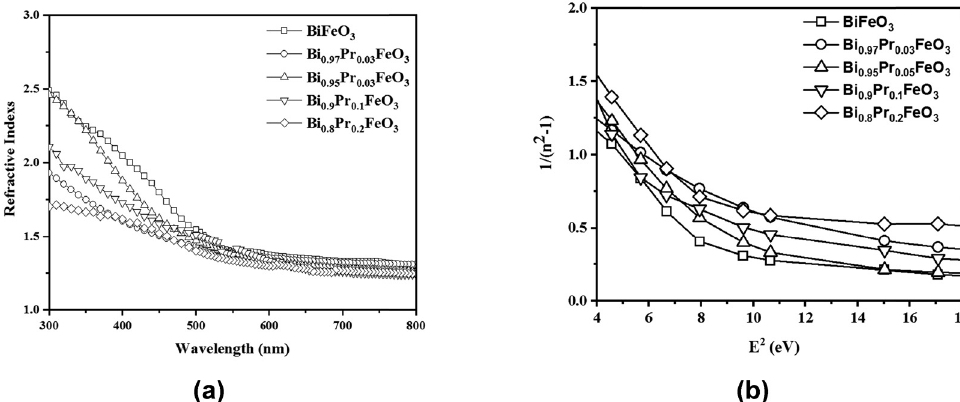
Figure 6: ( a ) Dispersion energy and ( b ) refractive index of BiFeO 3 and Bi 1 − x Pr x FeO 3 fi